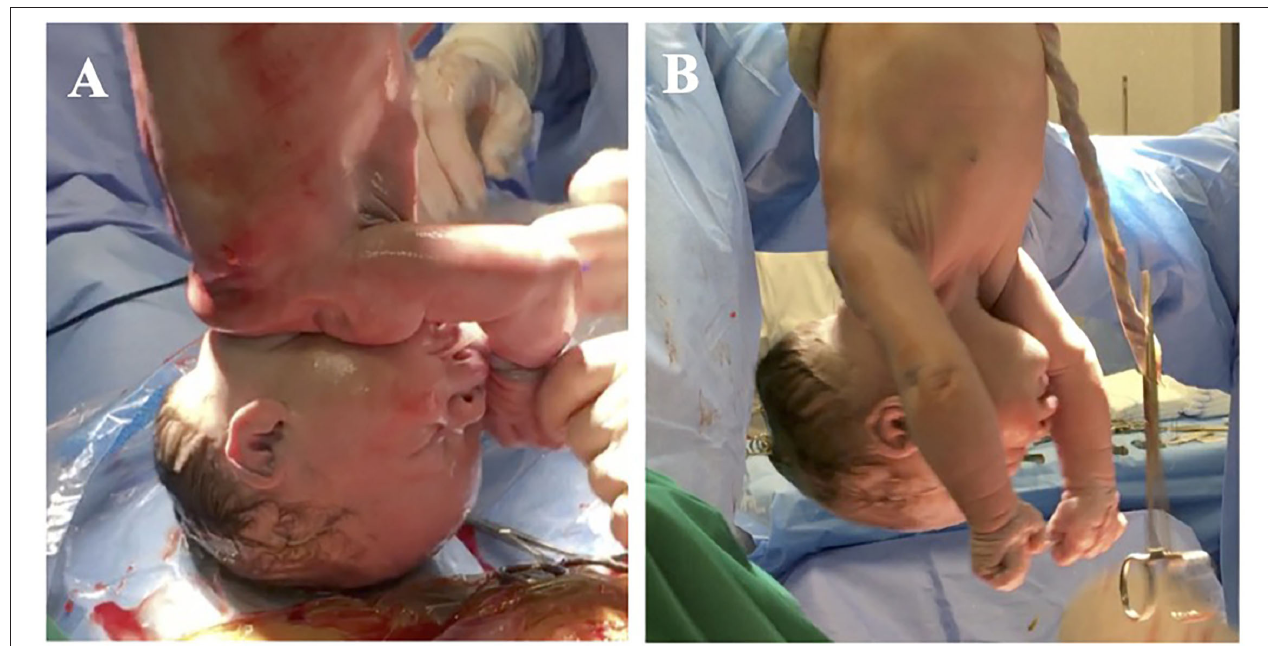
FIGURE 1 | The newborn immediately after birth. (A) Shows a baby 4s after birth, before the first breath occurs. Lungs are collapsed so that a large cavity is visible on the thorax. Muscles are flaccid and hang down. (B) Shows a baby 12s after birth, after the first breath, before crying. The cavity on the baby’s thorax is no longer visible and the muscles are visibly tonic. The color of the skin has changed, due to